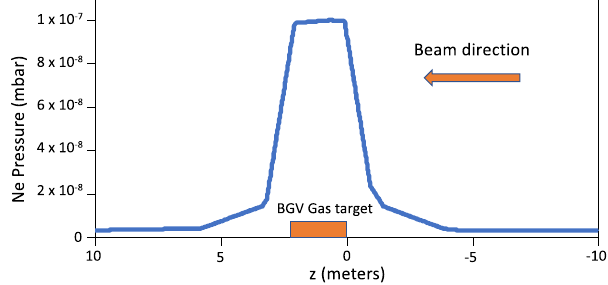
FIG. 2. Simulated longitudinal pressure profile along the BGV vacuum